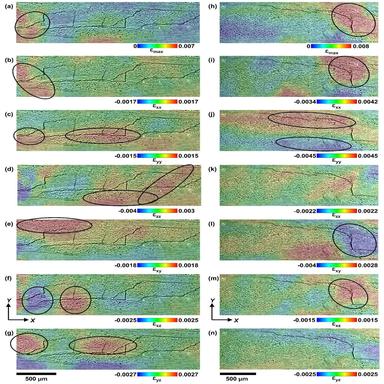
(a)-(g) Step1 (14 N) – Step2 (54 N) global DVC strains within material A tested at RT (A-RT-1) superimposed on the slice shown in a; (h)-(n) Step1 (9 N) – Step3 (52 N) global DVC strains within material A tested at 1050 C (A-1050-1) superimposed on the slice shown in. The strains were calculated prior to crack formation but are plotted on XCT slices showing fracture cracks to highlight correlation between localised strain and crack distribution.